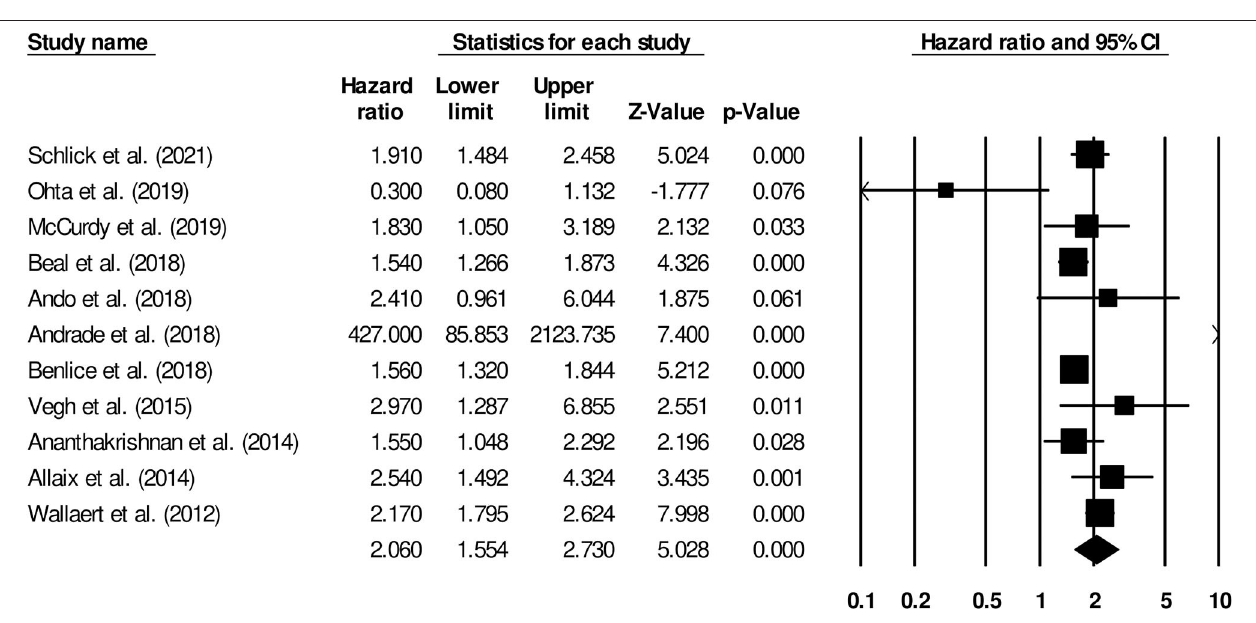
FIGURE 6 | Forest plot for studies evaluating the effect of steroids on the risk of venous thromboembolism in patients with inflammatory bowel disease. The hazard ratios are presented as black boxes; 95% confidence intervals are presented as whiskers. A small hazard ratio represents lower risks of venous thromboembolism in patients with inflammatory bowel disease, administered steroid drugs; a higher hazard ratio represents higher risks of venous thromboembolism in patients with inflammatory bowel disease, administered steroid